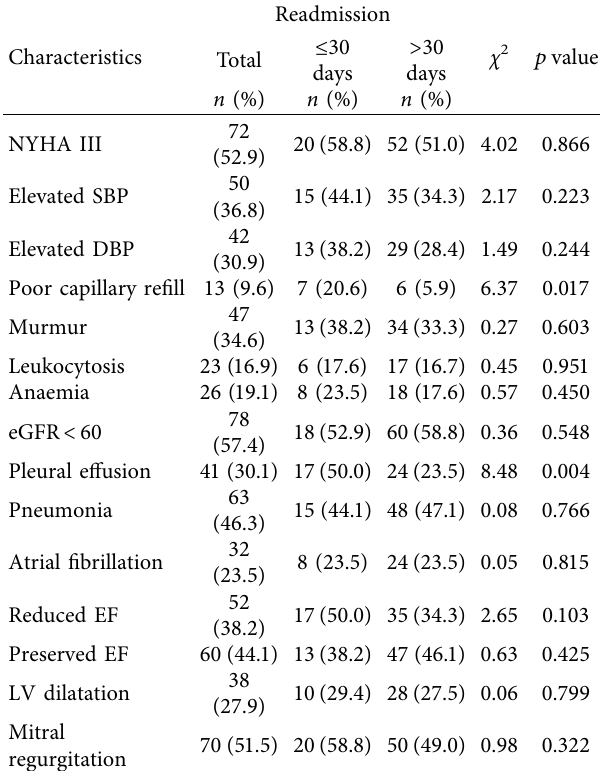
Table 2: Clinical characteristics of patients readmitted for heart failure ( N �